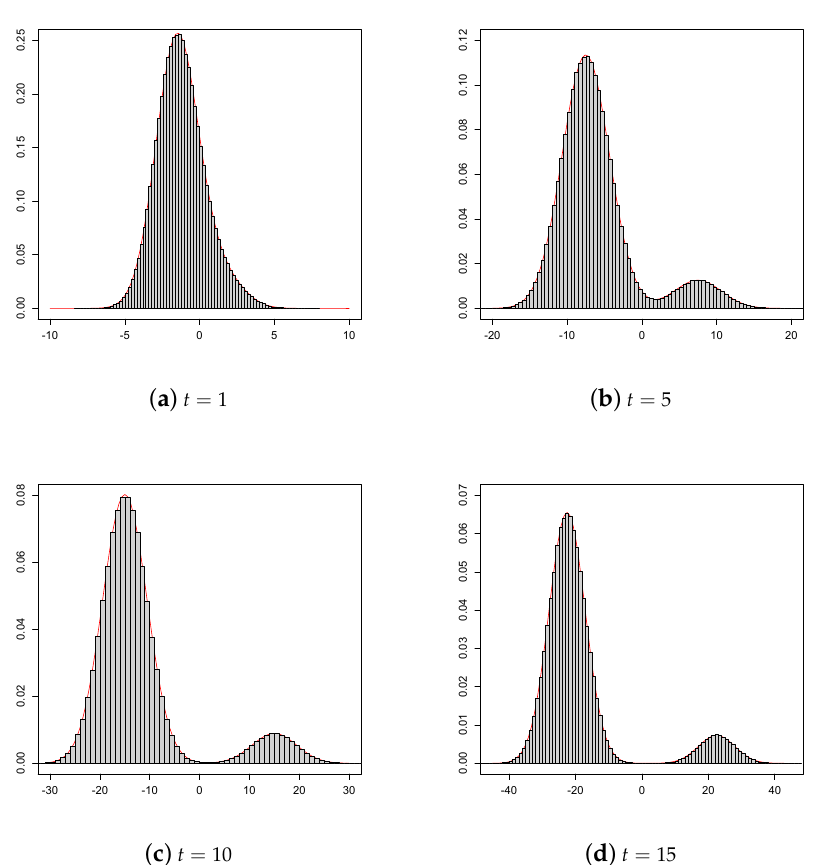
Figure 1. For the process Z ( t ) , having infinitesimal moments (32), with ϑ = 0.1, β ( t ) = 1.5 + 0.2 π sin ( 4 π t ) and σ 2 ( t ) = 2, the transition pdf (33) as a function of x is superimposed over a histogram obtained via Algorithm 1 for different choices of t .